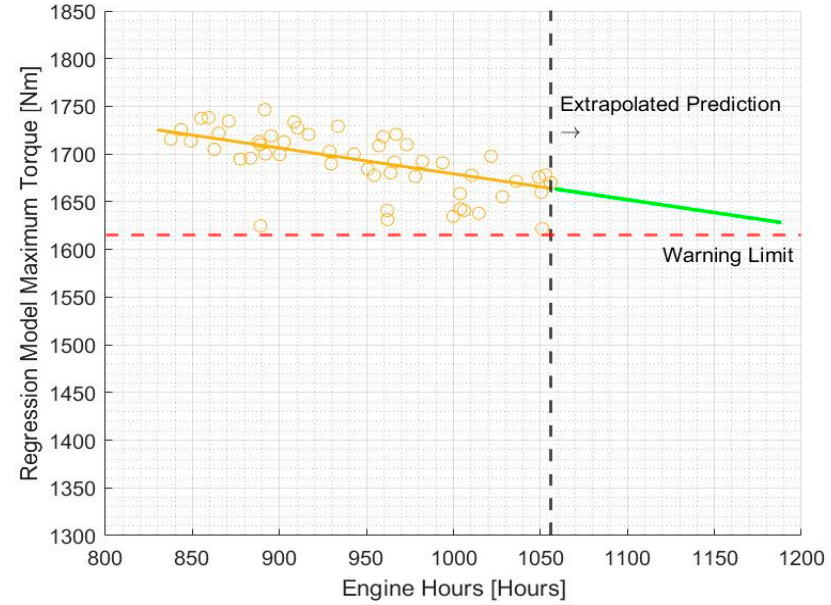
Figure 14. Maximum torque trend predicted by regression model based on linear SVM.